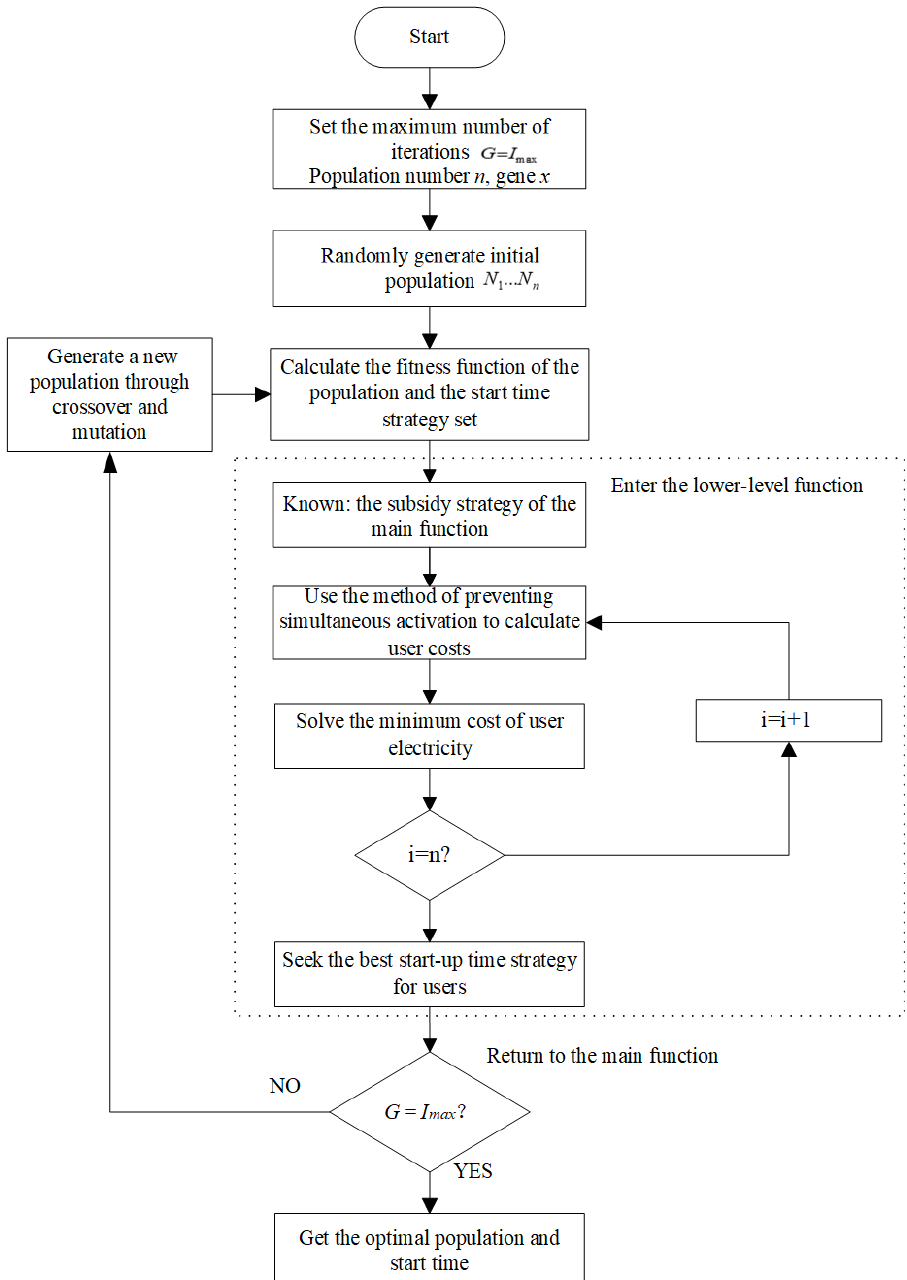
Figure 3. Flow chart of Two-layer algorithm.